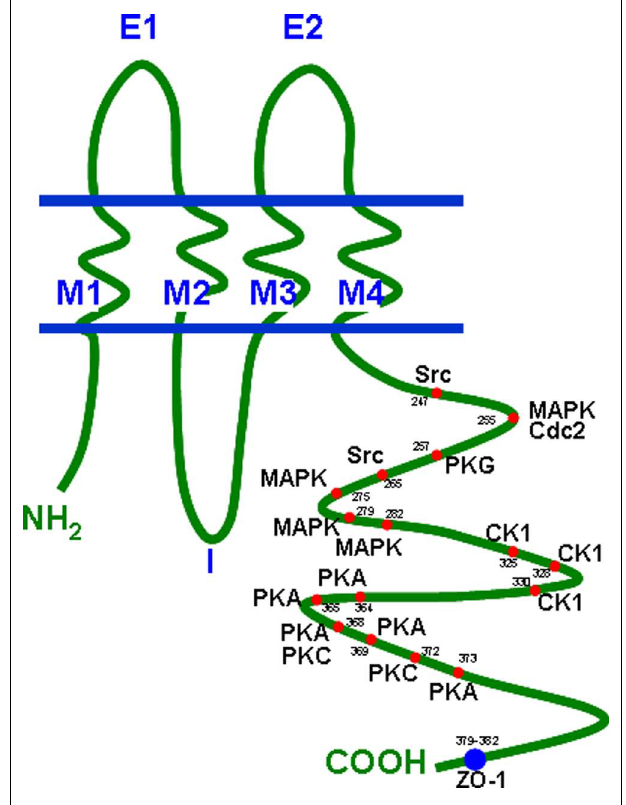
FIGURE 1 | Connexin topology with phosphorylation sites and ZO-1 binding region. Cdc2, cyclin dependent kinase 2; CK1, casein kinase 1; MAPK, mitogen-activated protein kinase; PKA, protein kinase A; PKC, protein kinase C; PKG, protein kinase G; ZO-1, zonula occludens protein 1.